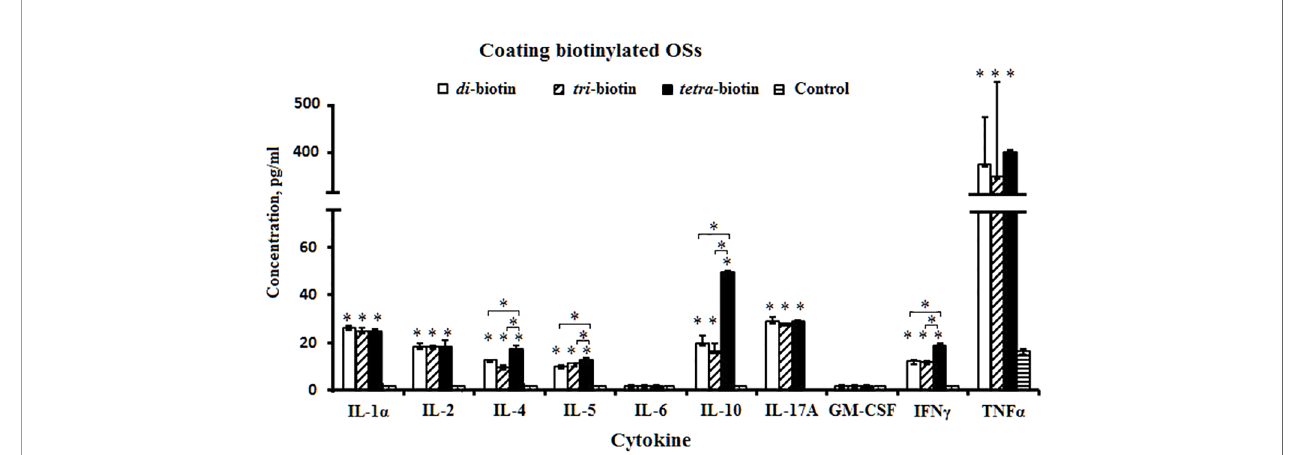
FIGURE 3 | Levels of cytokine formation induced by biotinylated di-, tri-, and tetrasaccharides related to CP of S. pneumoniae type 3. The bars represent cytokine concentrations of triplicate evaluations of samples from mice (n = 6) in each group. Data are presented as a mean value ± SD. Mann – Whitney Rank Sum tests were used to determine signi fi cance between control and designated groups. * P < 0.05.